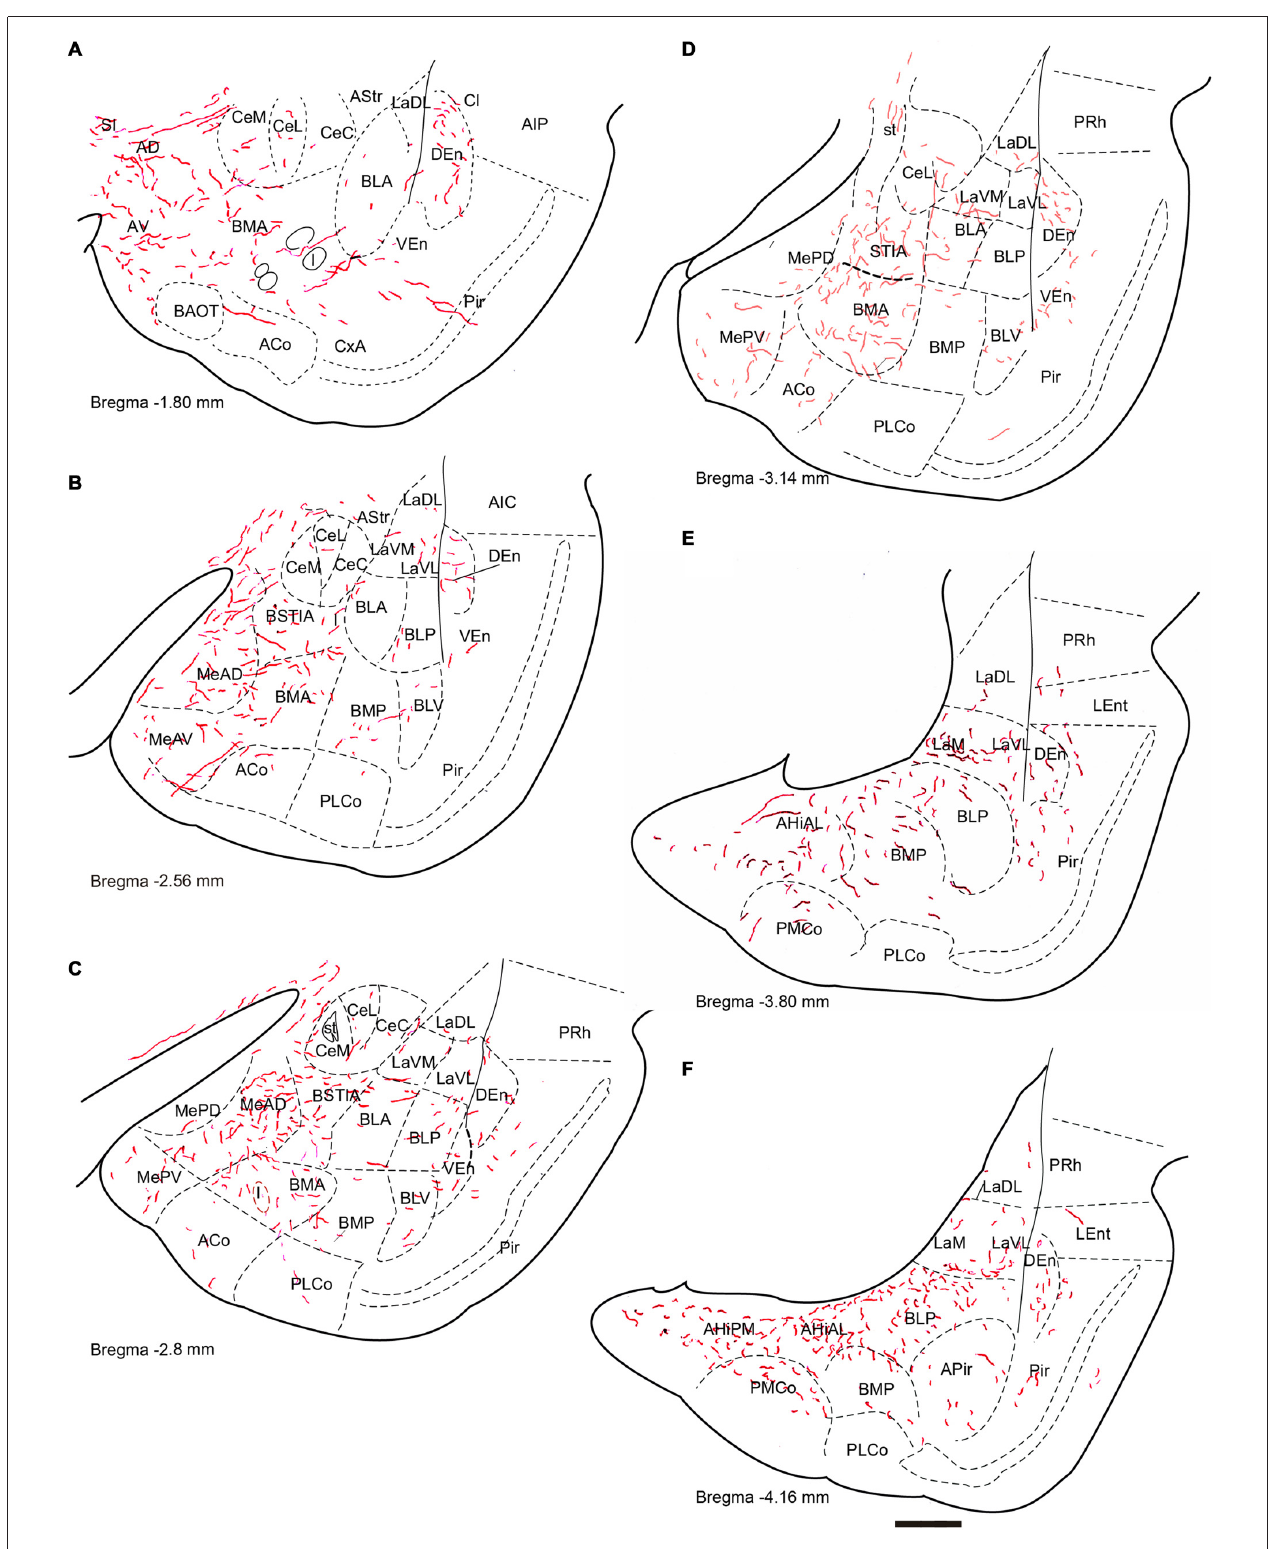
FIGURE 2 | Distribution of anterograde fiber labeling in the temporal amygdala (TA) from a case with a BDA injection into the NI. Labeled fibers occurred mainly in the medial aspects of the themporal amygdala and in a broad band in the basal nuclei. (A–F) Represents camera lucida drawings of the corresponding bregma levels. Calibration bar 500 µ